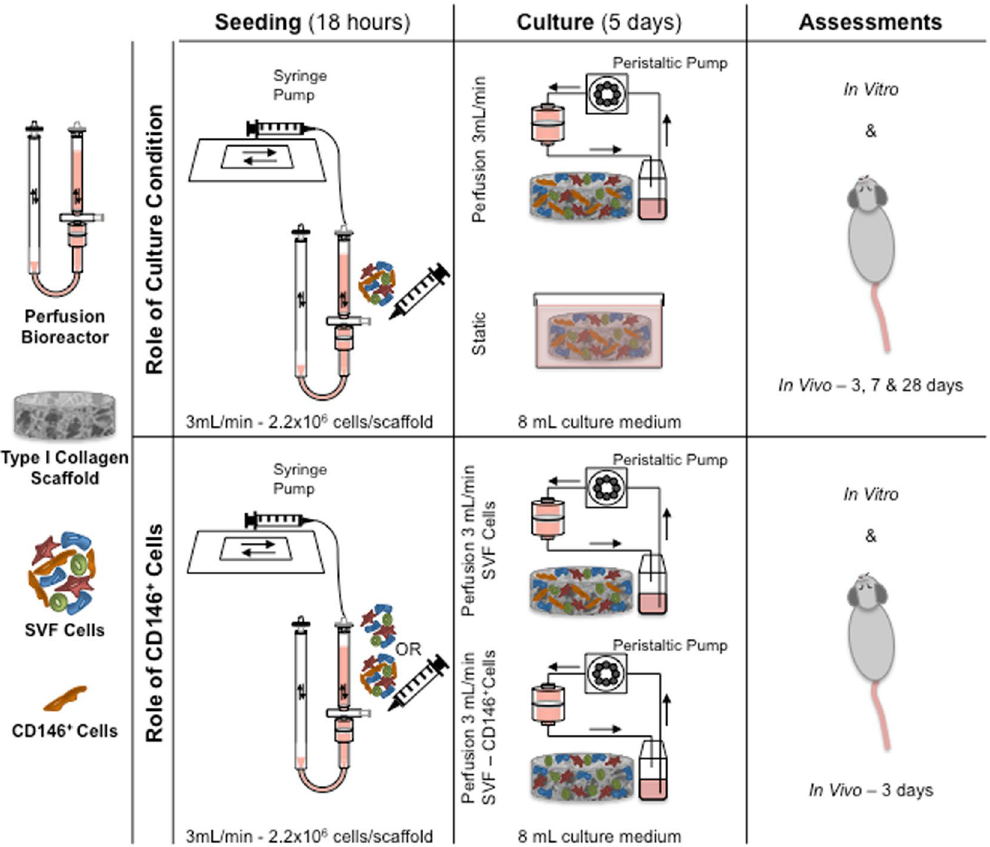
Figure 1. Scheme of the study. Summary of the main steps of the experimental